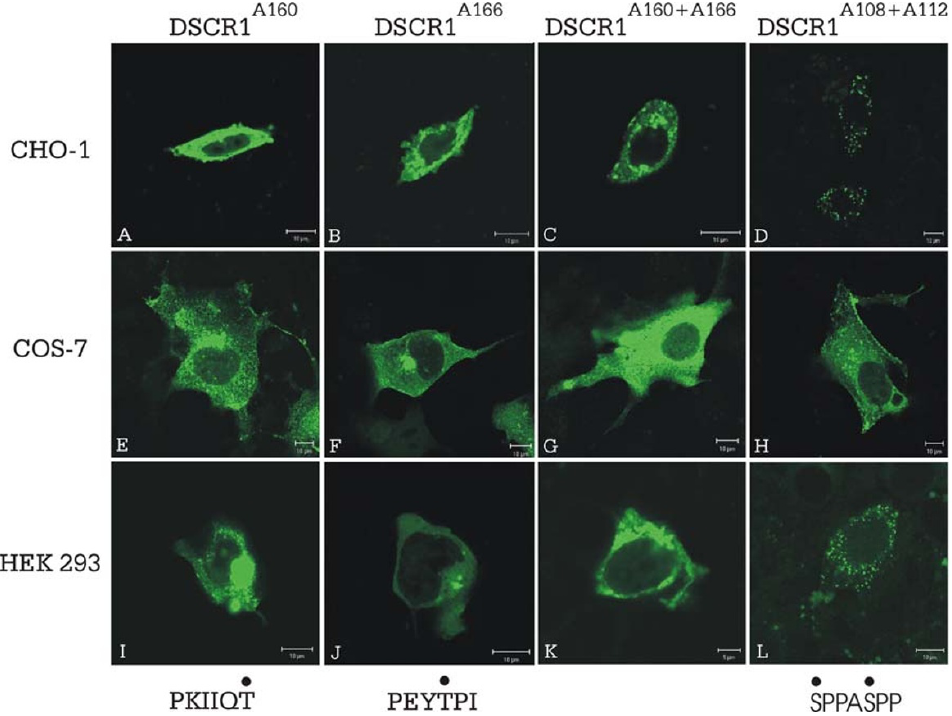
Figure 3 Confocal laser scanning microscope images of distinct DSCR1-punctual mutants expression in CHO-1 (line 1, A-D), COS-7 (line 2, E-H) and HEK 293 cells (line 3, I-L). Subcellular location of: DSCR1 A160 (A, E, I), DSCR1 A166 (B, F, J), DSCR1 A160+A166 (C, G, K) and DSCR1 A108+A112 (D, H, L). The different constructions obtained by site-directed